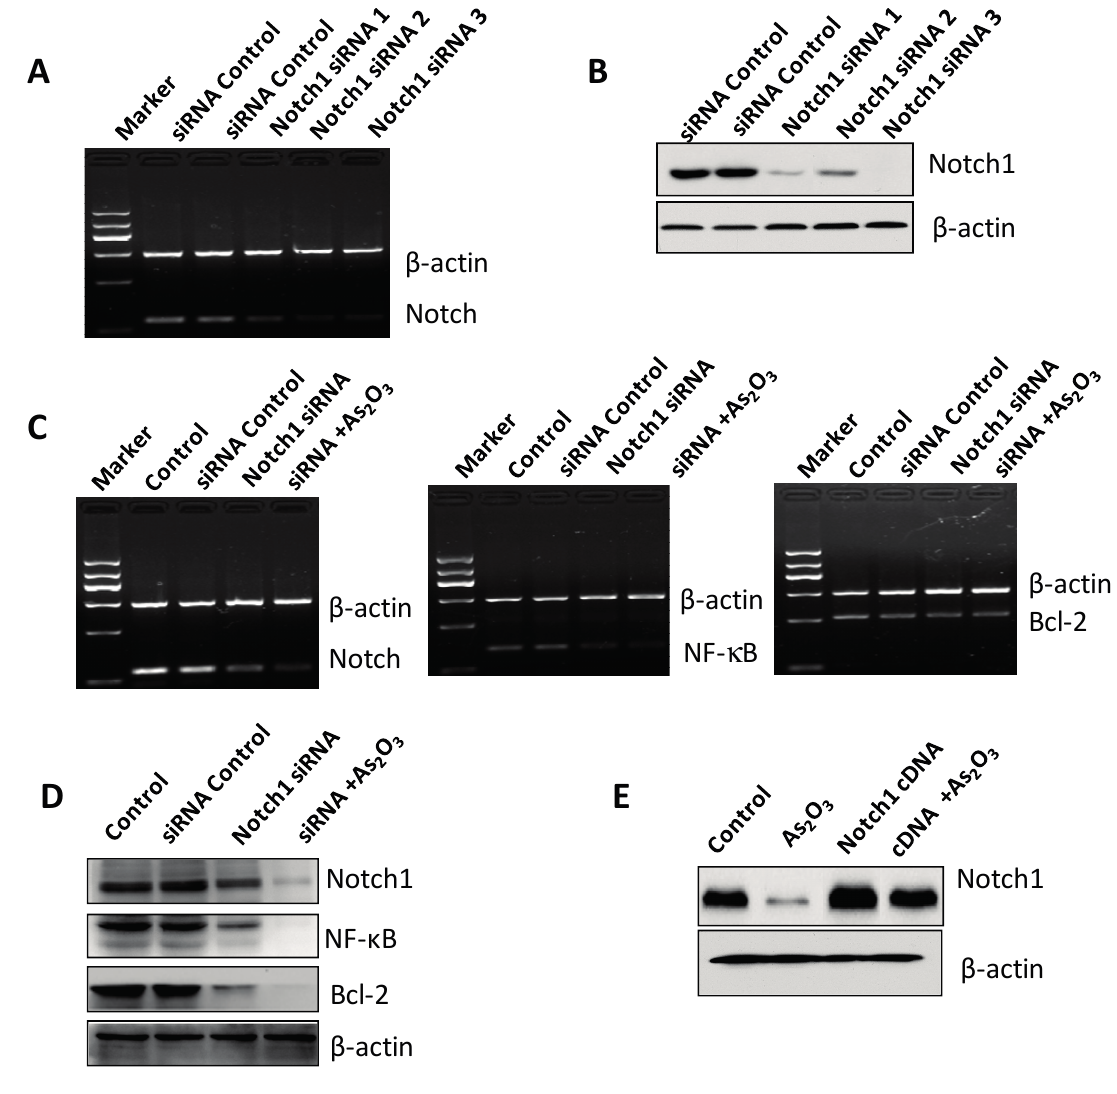
Figure 5. The efficacy of transfection by Notch-1 siRNA and Notch-1 cDNA in SKBR-3 cells. A - D : The expression of Notch-1 was detected by RT-PCR and Western blotting, respectively, to check the Notch-1 siRNA transfection efficacy; E : The expression of Notch-1 was detected by Western blotting for assessing the Notch-1 cDNA plasmid transfection efficacy.